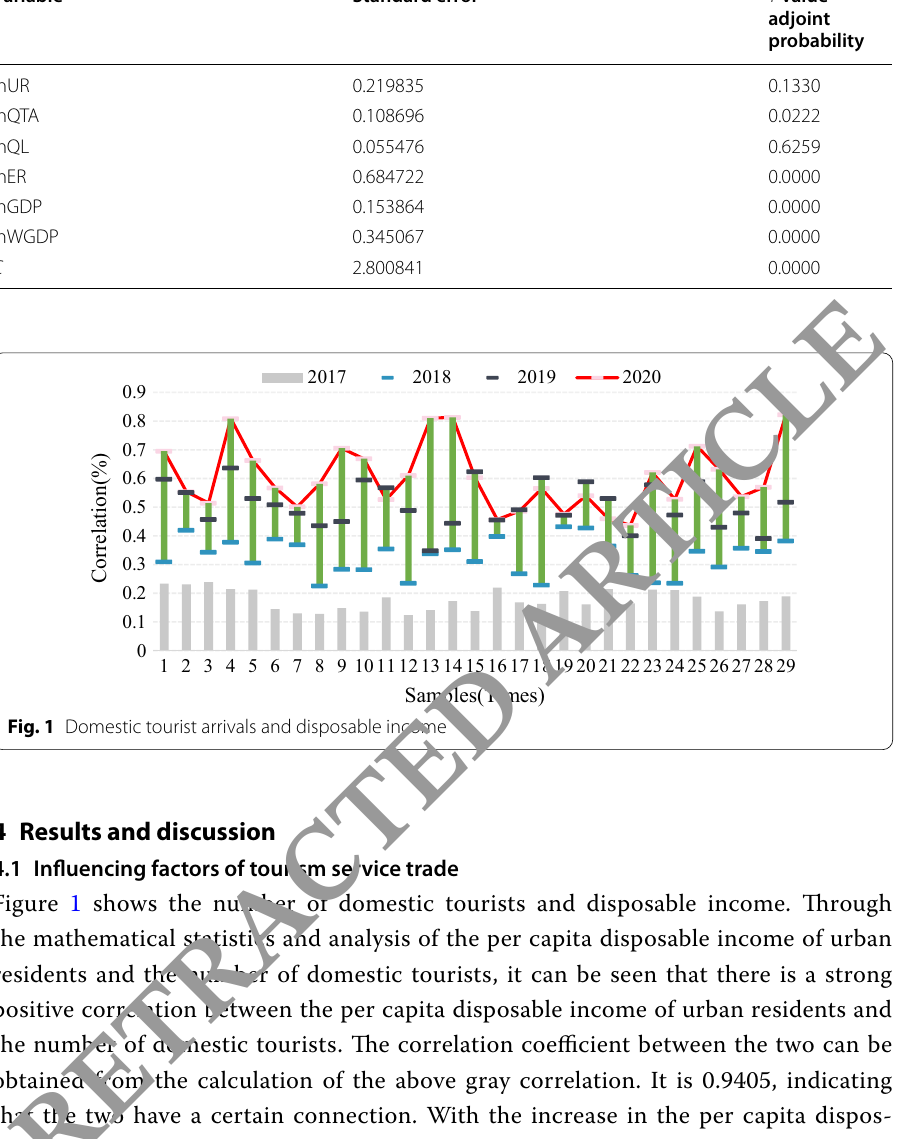
Table 1 Regression of the model Variable